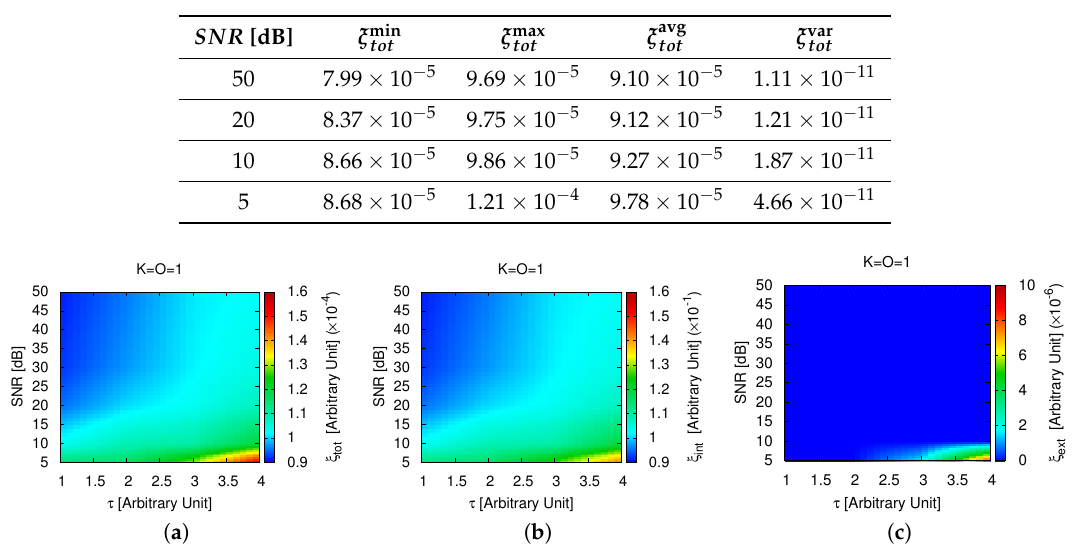
Figure 3. Numerical Assessment ( K = 1, O = 1, τ = 1.0) - MT-BCS reconstructions when processing the scattering data with ( a ) SNR = 50 [dB] ( (cid:98) τ = 0.81); ( b ) SNR = 20 [dB] ( (cid:98) τ = 0.79); ( c ) SNR = 10 [dB] ( (cid:98) τ = 0.78), and ( d ) SNR = 5 [dB] ( (cid:98) τ = 0.77). Table 1. Numerical Assessment ( K = 1, O = 1, τ = 1.0, W = 100, MT-BCS )—Total error statistics.